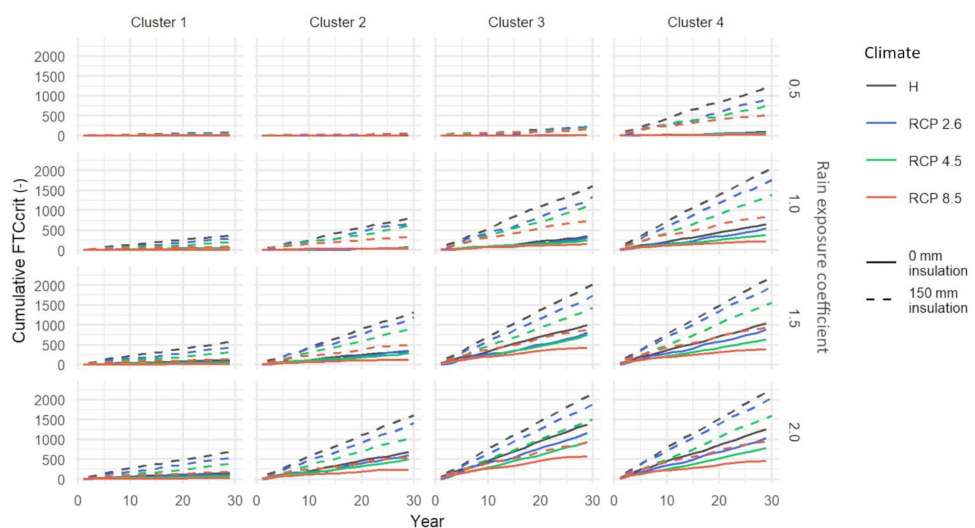
Figure 8. Cumulative number of FTC crit for the 300 mm masonry wall at the SW orientation for the historical period (H) and RCP projections.